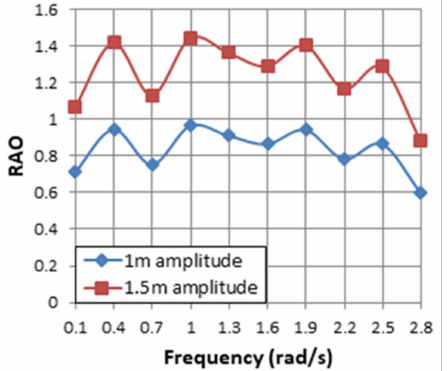
Figure 11. The RAO and power extracted by the central body with 0, 15 and 30 degrees of incident wave